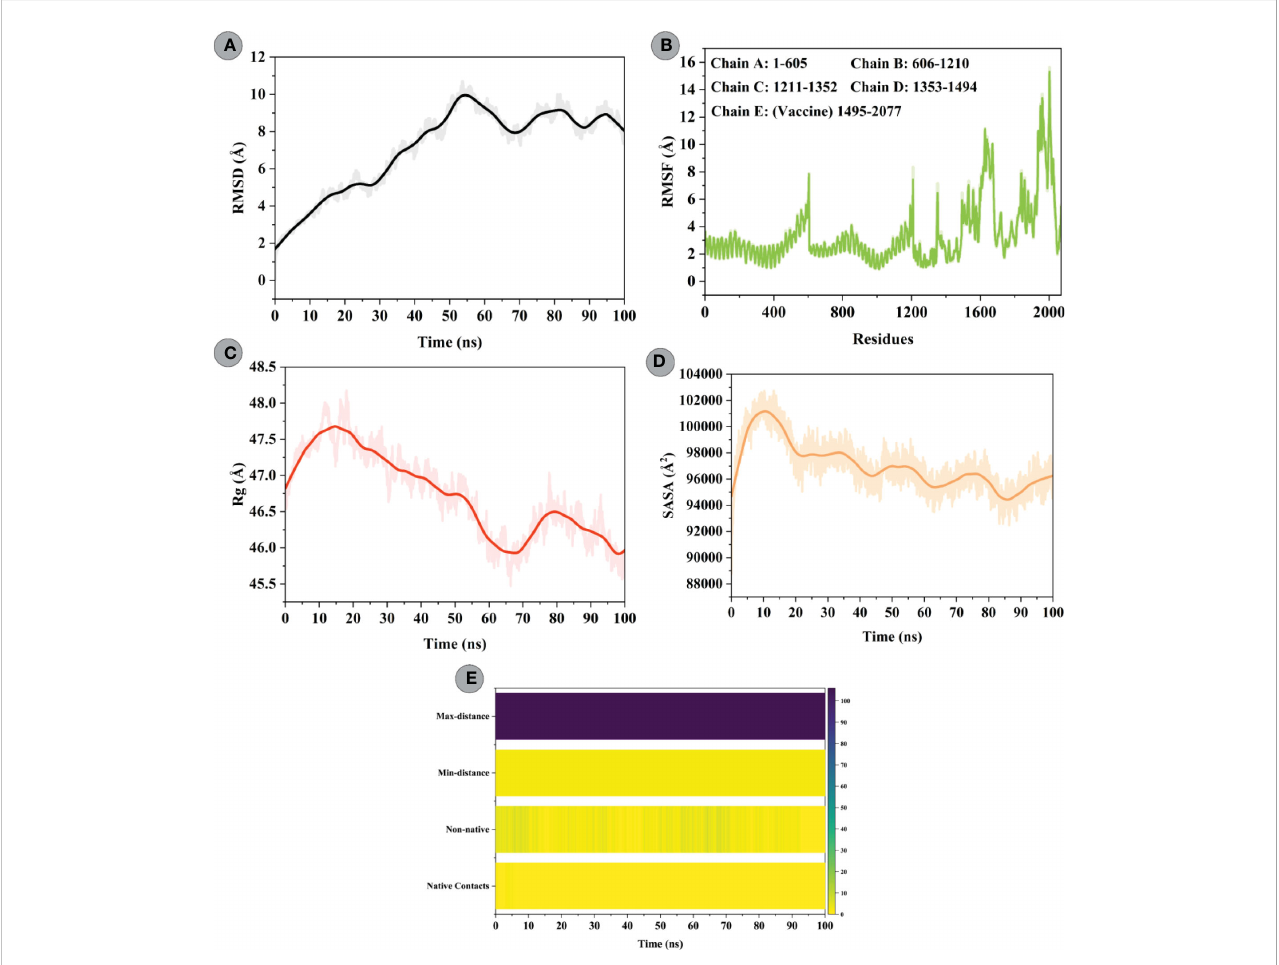
FIGURE 8 Molecular dynamics simulations study of modelled vaccine (ligand) and TLR4 (receptor) complex. (A) Root Mean Square Deviation (RMSD) plot of ligand and receptor complex present no signi fi cant displacement, indicating stable molecular interaction between two molecules. (B) Root Mean Square Fluctuation (RMSF) plot of the ligand-receptor complex representing the mobility of individual amino acid side chains. Amino acids of TLR4 goes from 1 to 1494, while that of vaccine construct starts from 1495 till the end. (C) The radius of Gyration (Rg) plot of ligand-receptor complex showing the structural compactness over 100ns timescale. (D) Solvent Accessible Surface Area (SASA) plot of ligand-receptor complex indicating changes in the surface volume of the complex over time (100ns). (E) Native and non-native contacts between the modelled vaccine – TLR4 complex over the simulation